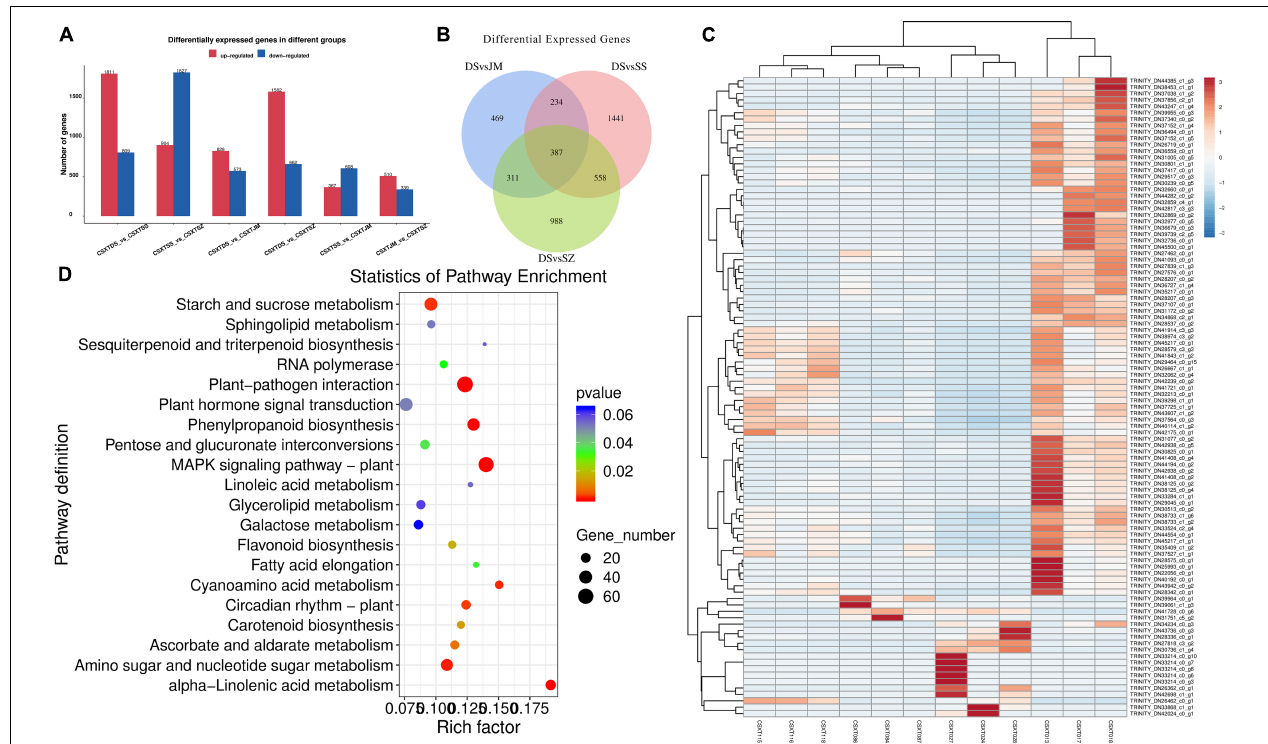
FIGURE 3 | Statistics of differentially expressed genes. (A) Number statistics of differentially expressed genes; (B) Veen map of Danxia stone; (C) Differential gene clustering heat map; and (D) Enrichment of KEGG pathway of differential